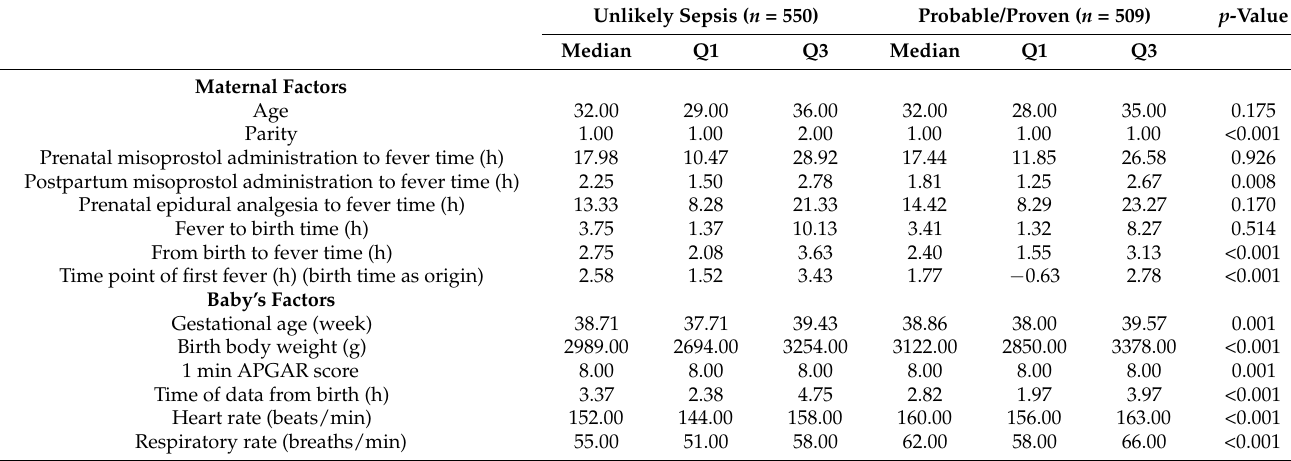
Table 1. Relationship between perinatal factors and neonatal sepsis.